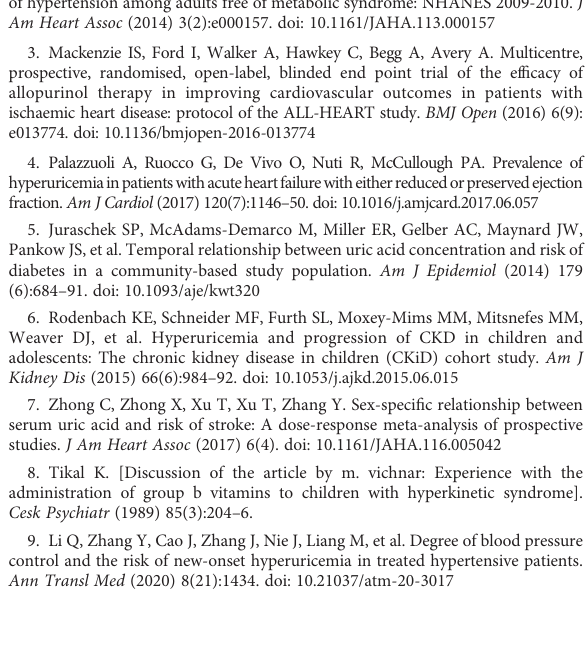
SUPPLEMENTARY TABLE 1 Odds ratios and 95% CIs for hyperuricemia according to WC as continuous variables and quartiles